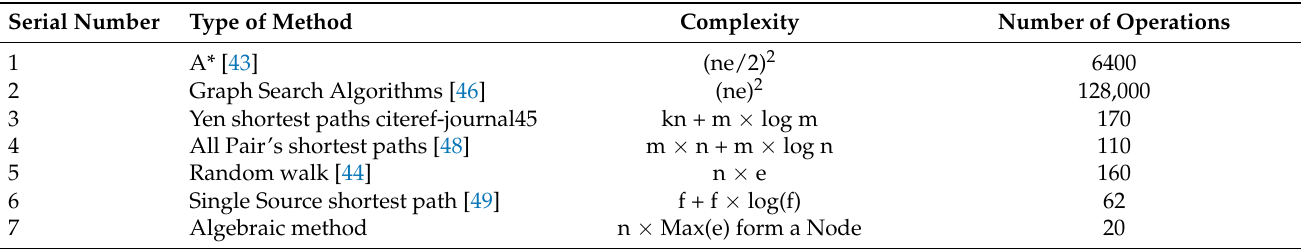
Table 5. Complexity analysis of different methods used for path generation.